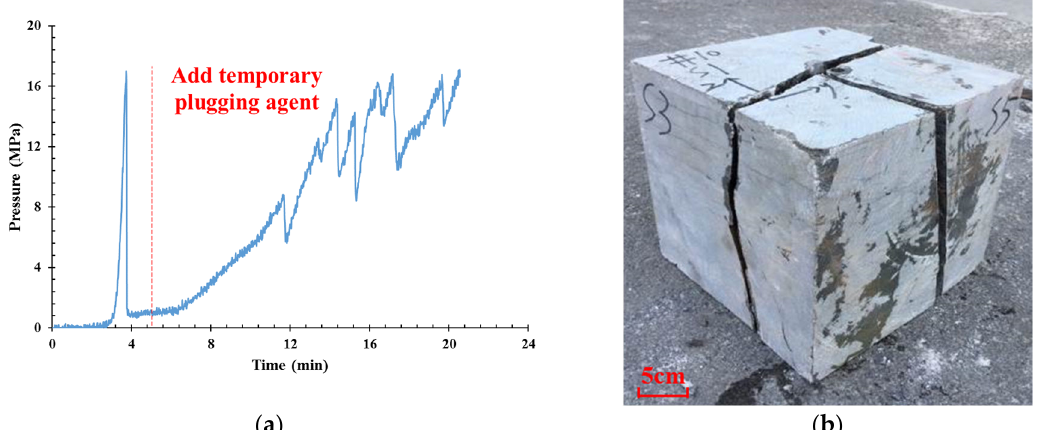
Figure 4. Pressure curve and fracture geometry of diversion experiment at the inlet of the fracture. ( a ) Pressure curve; ( b ) Fracture geometry.